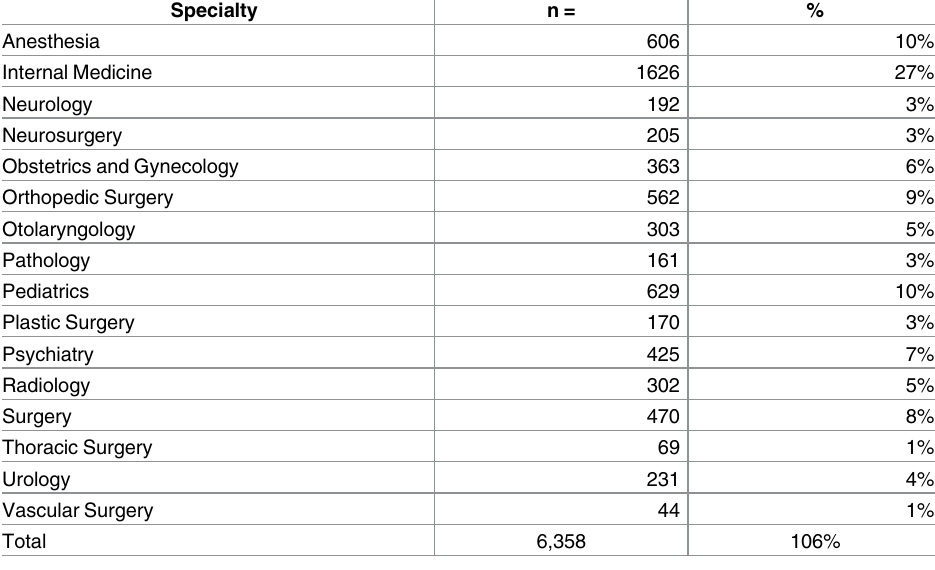
Table 3. Population specialty